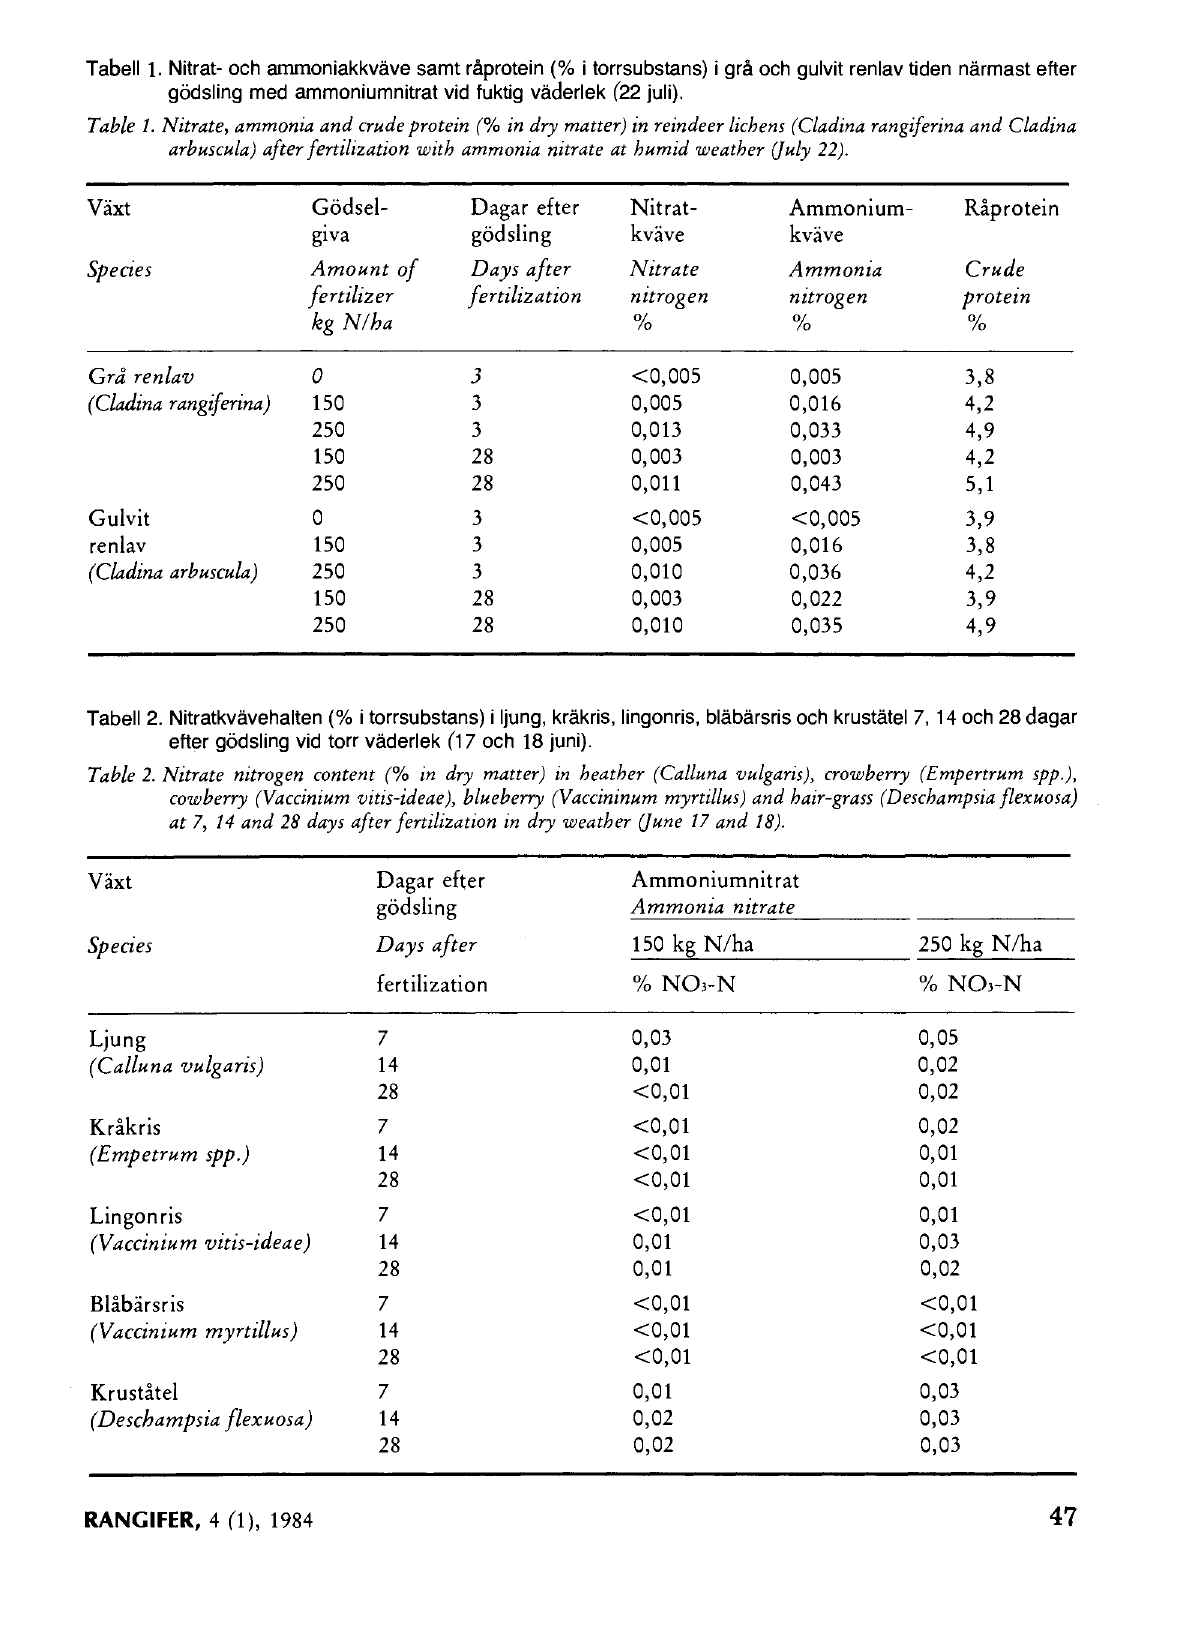
Table 1. Nitrate, ammonia and crude protein (% in dry matter) in reindeer lichens (Cladina rangiferina and Cladina arbuscula) after fertilization with ammonia nitrate at humid weather (July 22).